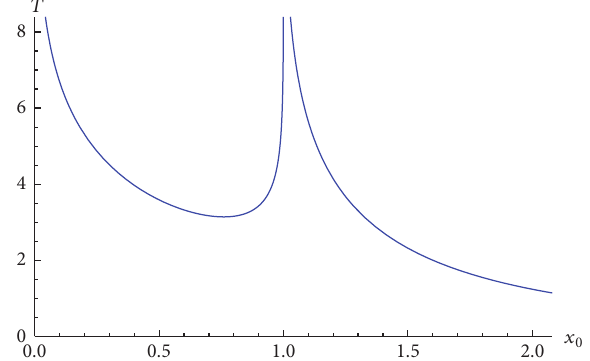
Figure7:Exactperiod T asafunctionoftheinitialposition 𝑥 0 when = −1 and 𝑎 = 3 , (a) 𝑥 > (−3𝑎 /𝑎 ) 1/4 = 1 , Section 4 (17), and 𝑎 1 5 0 1 5 (b) 𝑥 0 < (−3𝑎 1 /𝑎 5 ) 1/4 = 1 , Section 3 (49). As can be seen the motion is not periodic when the initial position is 𝑥 = (−3𝑎 1 /𝑎 5 ) 1/4